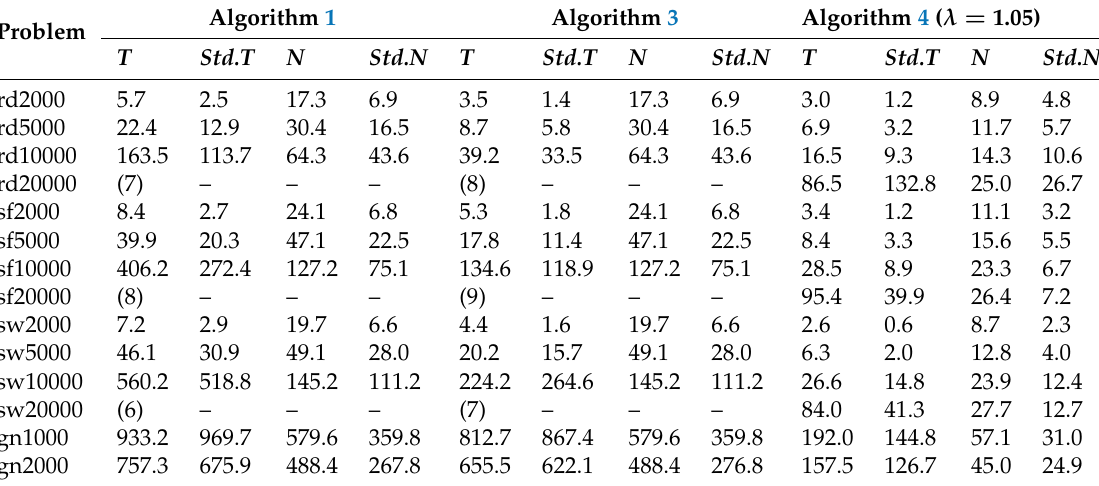
Table 3. The computational results for networks of different scale and different types.